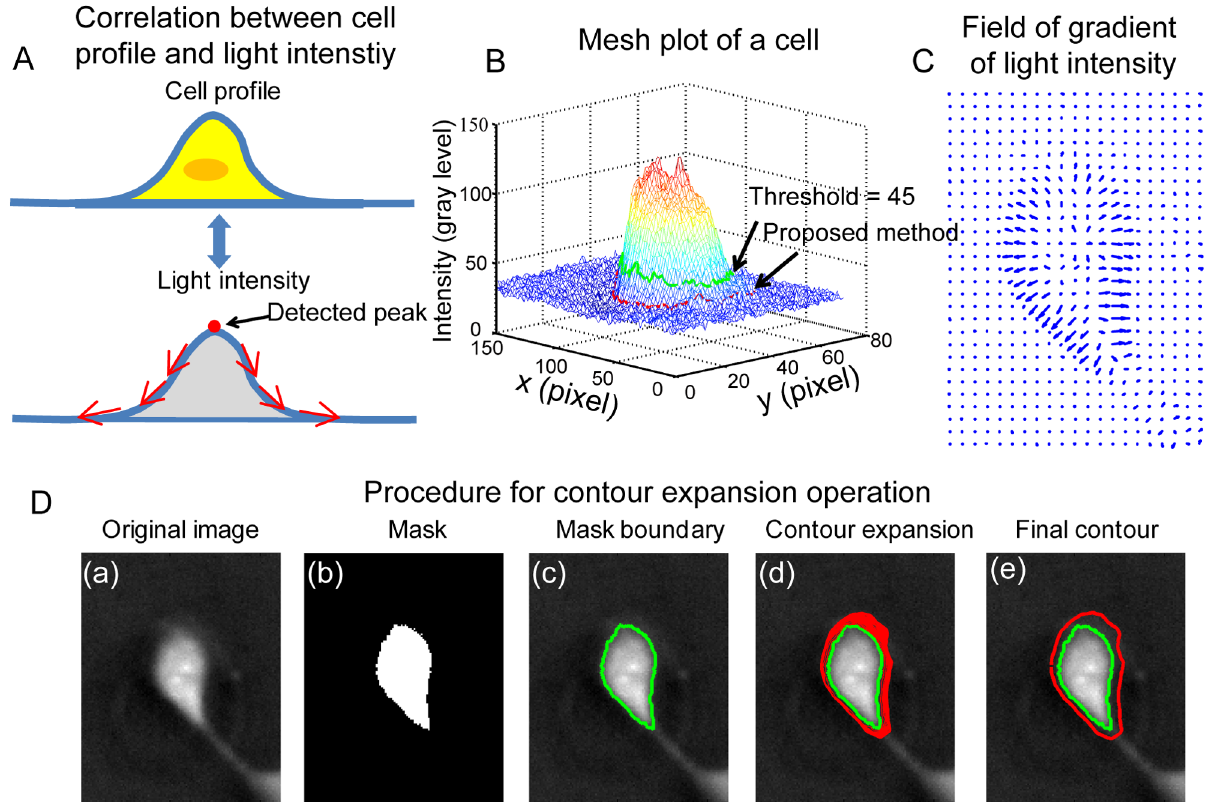
Fig 3. Contour expansion method for cell boundary detection. (A) It is assumed that cells have illustrated height profile with one peak located above cell nucleus. In negative phase contrast images, the light intensity of cells is proportional to cell height. Therefore, the light intensity distribution over cell surface is similar to height profile of cells with one peak located above each cell body. (B) Mesh plot of the light inteisity for a selected cell marked with yellow arrows in Fig 2A and 2B. The light intensity decreases towards the cell boundary, which is consistent with the illustration shown in (A). (C) Quiver plot of the gradient of light intensity for the selected cell. Over cell surface, the gradient of light intensity pointing outwards. (D) The procedure of the contour expansion method for cell boundary detection: (a) The raw negative phase contrast image of the selected cell. (b) The thresholding method was used to get a preliminary mask for the selected cell. (c) The boundary of the mask was extracted and taken as the initial contour. (d) With contour expansion method, the initial contour is driven by the field of gradient of light intensity to gradually converge to the cell boundary. (e) The contour is finally converged at the boundary of the cell, where the contour achieves the minimum energy. The comparison of the contour detected with the thresholding method and the proposed method is shown in (B). It is clear that the proposed method provides an improved estimation of the cell